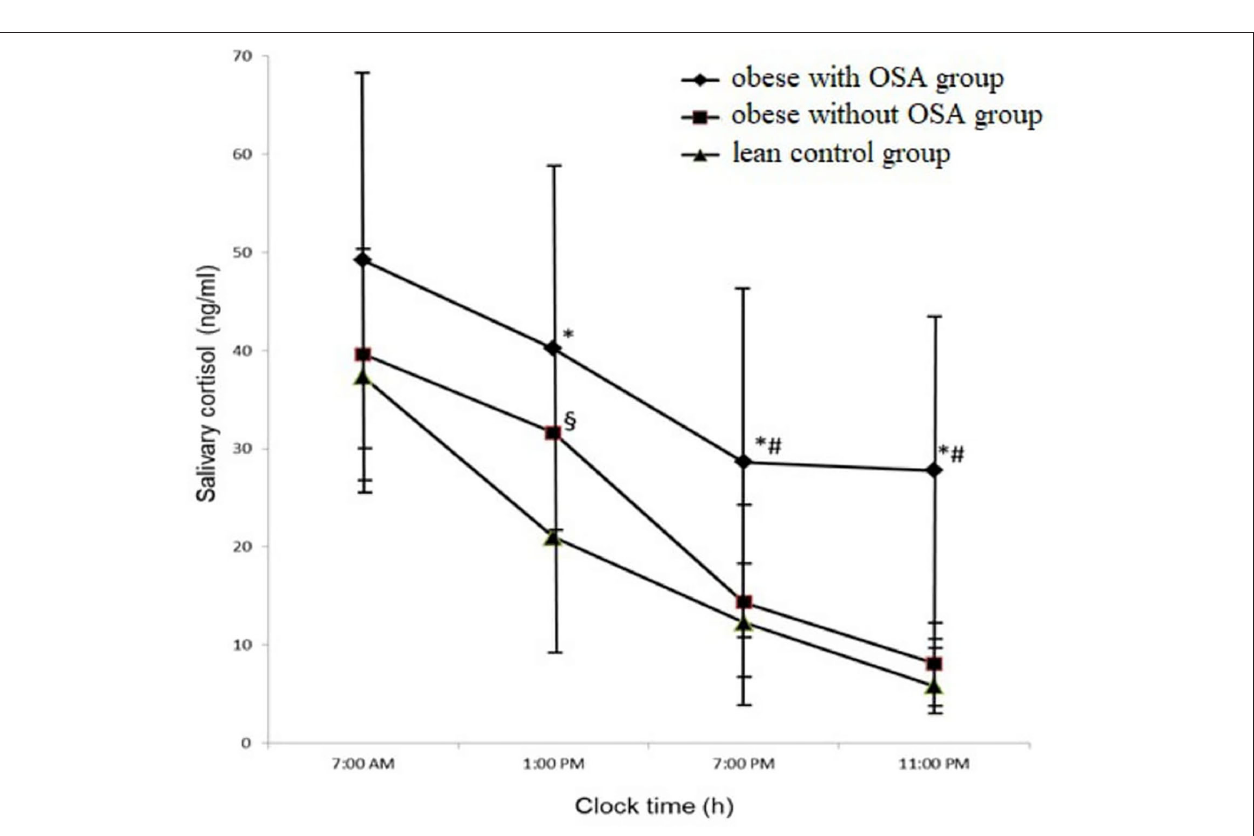
FIGURE 1 | The circadian trajectories of salivary cortisol in the study population. Results were expressed as mean with standard deviation (M ± SD). * p < 0.05 for the obese with OSA group value vs. the lean control group value; # p < 0.05 for the obese with OSA group value vs. the obese without OSA group value; § p < 0.05 for the obese without OSA group value vs. the lean control group value. OSA, Obstructive sleep apnea.